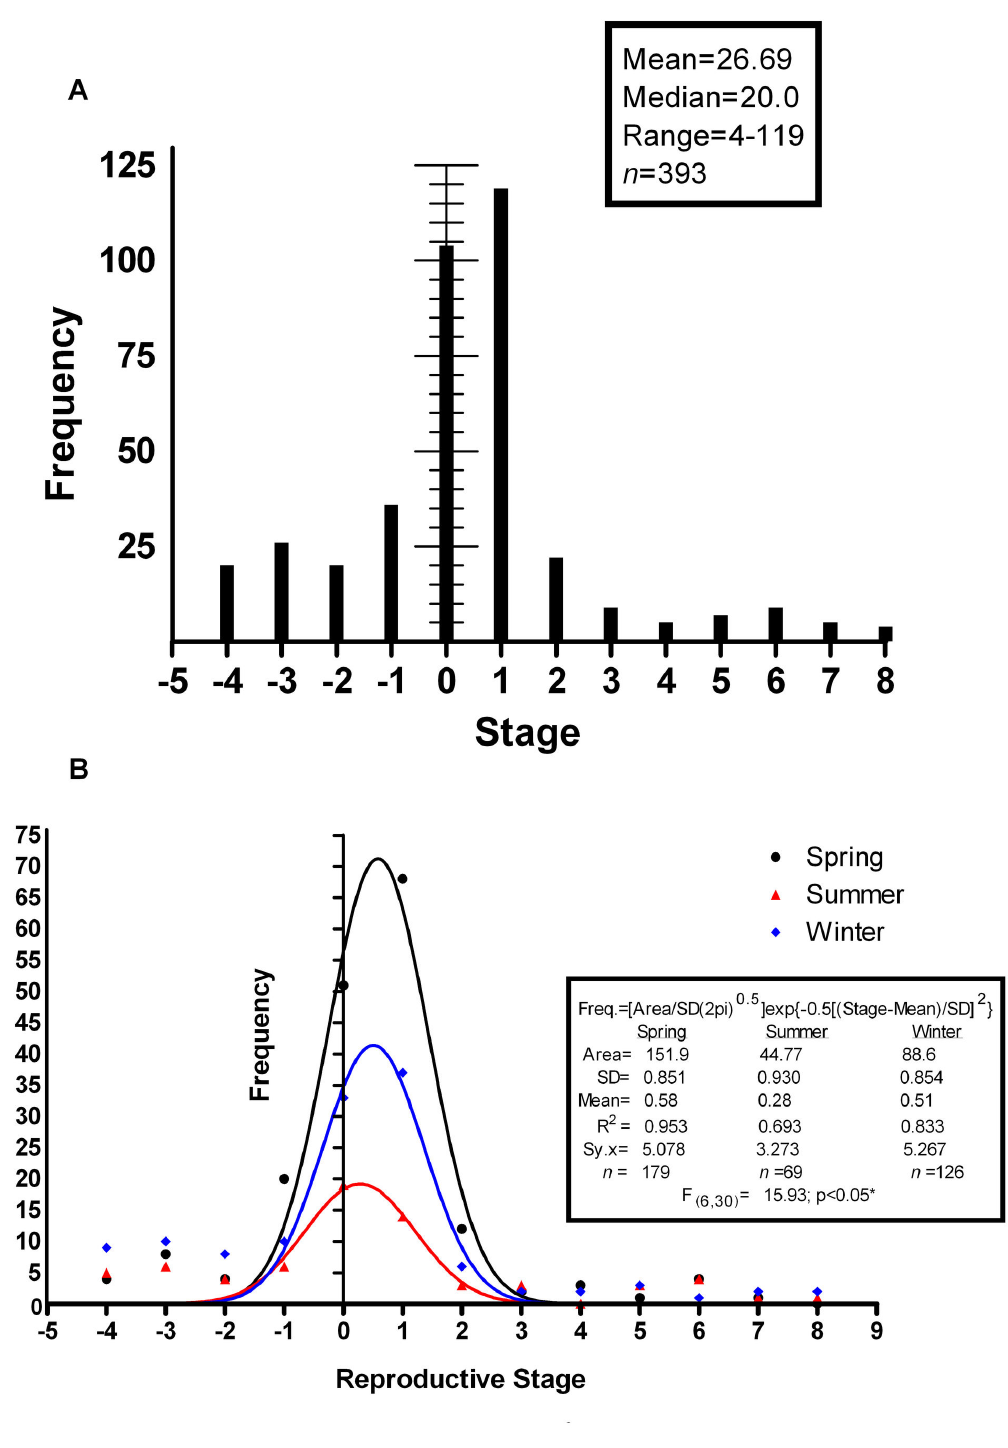
Figure 10. Reproductive status and seasonal patterns. (a) A frequency histogram for the reproductive stages introduced in Table 1. The majority of animals sampled in this study were either sexually undifferentiated or in the earliest stages of female gonadal development. (b) A seasonal comparison of the distribution of reproductive stages. The general pattern of distribution is similar in all seasons. Spring differs from other seasons in area but Spring, Summer, and Winter do not differ in Mean and SD. doi: 10.1371/journal.pone.0078740.g010 PLOS ONE |